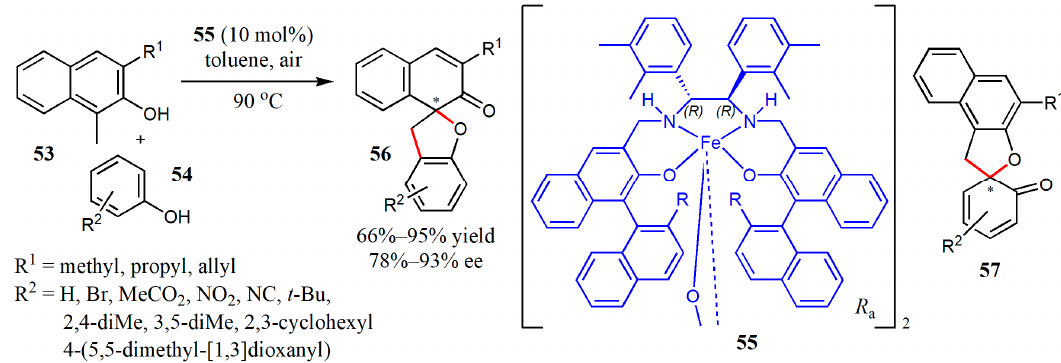
Figure 17. Iron-catalyzed aerobic oxidative dearomatizing spirocyclization of 2-naphthols.